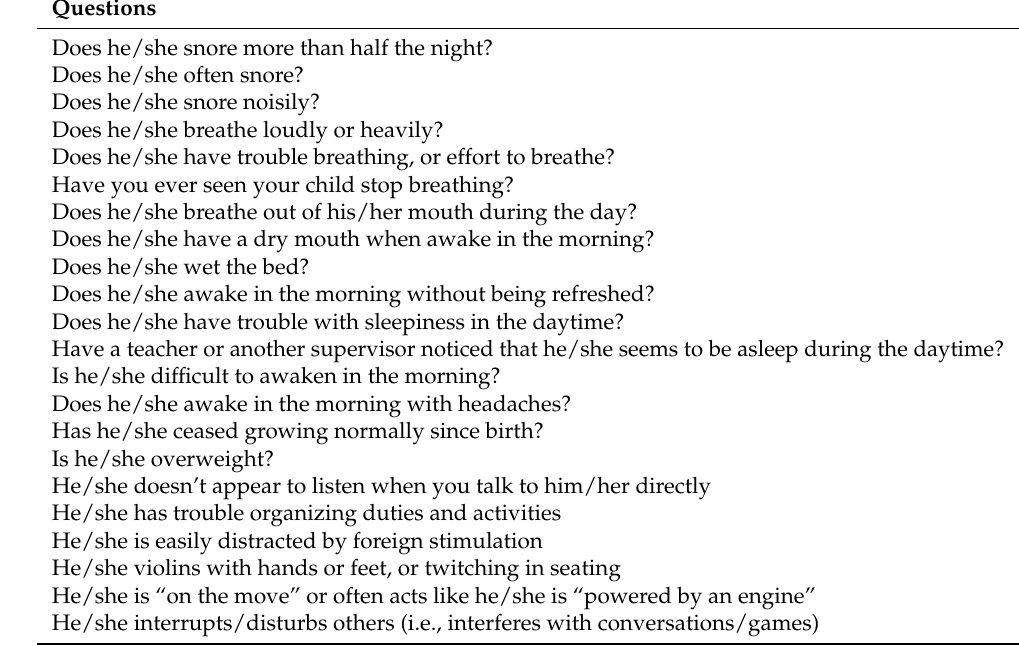
Table 1. Pediatric sleep questionnaire items